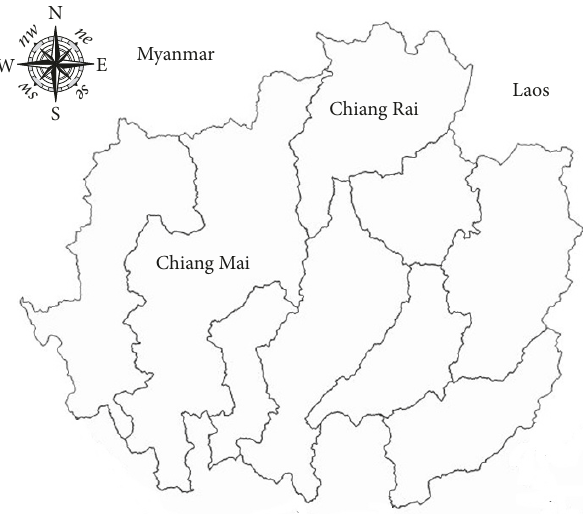
Figure 1: Geographical location of Chiang Mai and Chiang Rai provinces in northern